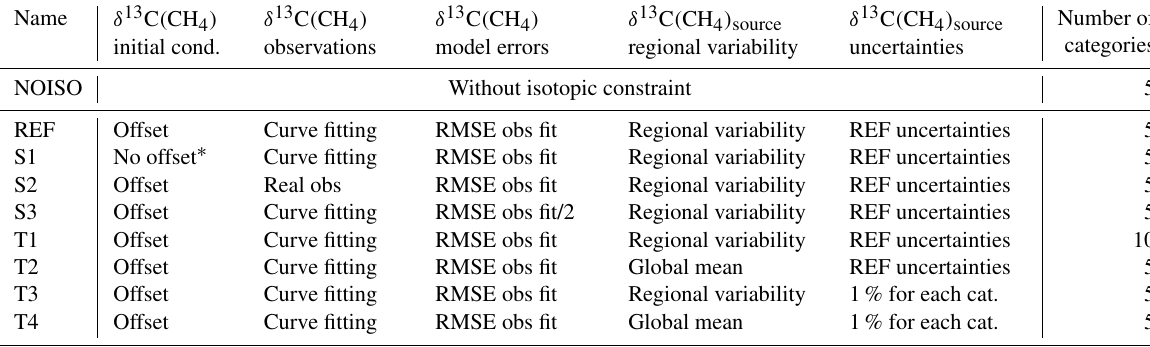
Table 2. Nomenclature and characteristics of the configurations. Details are provided in Sect. 2.4.4.